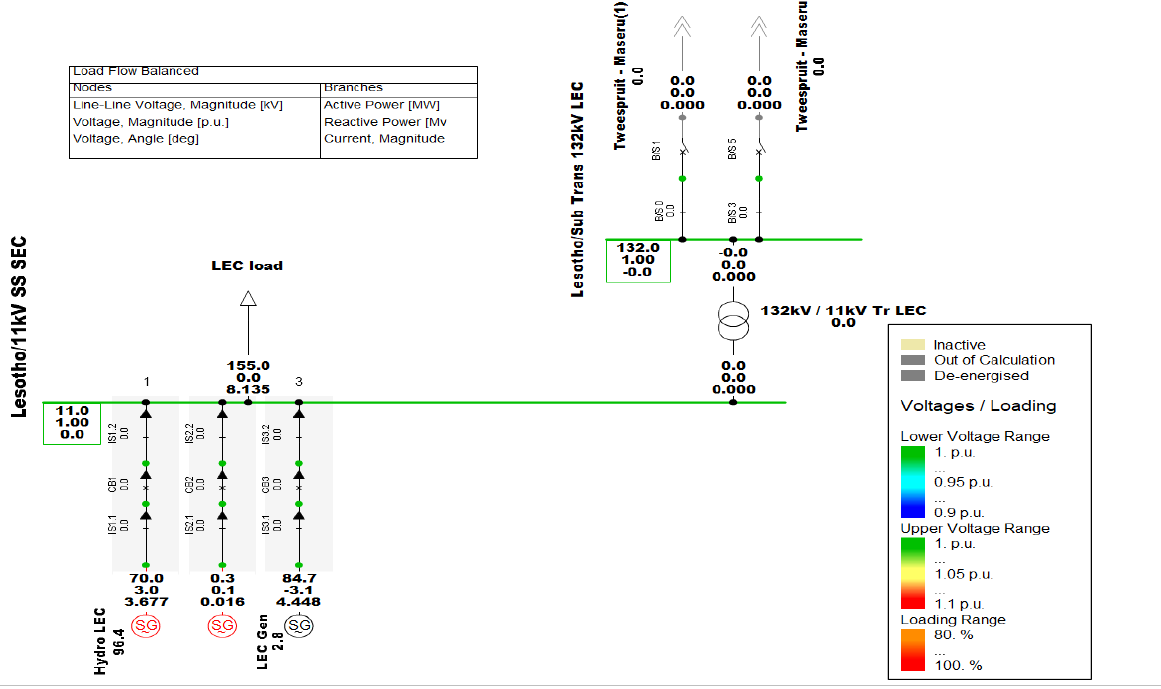
Figure 6. Lesotho network model.